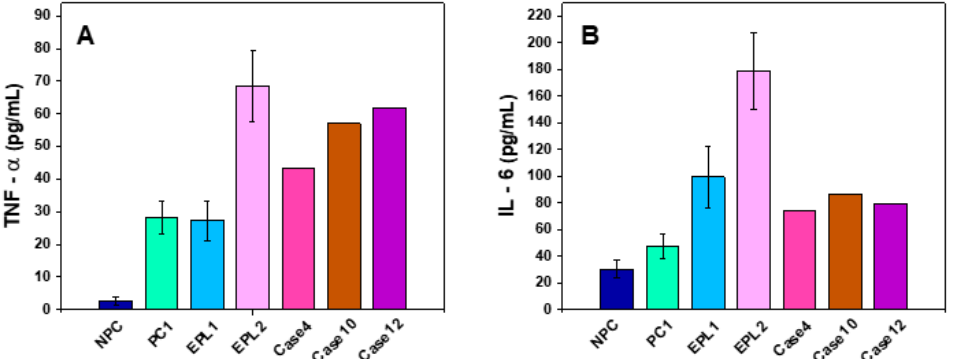
Figure 3. TNF- α ( A ) and IL-6 ( B ) cytokine levels determined for non-pregnant women (NPC), pregnant women in the first trimester of pregnancy (PC1), and for patients with early pregnancy loss (EPL).